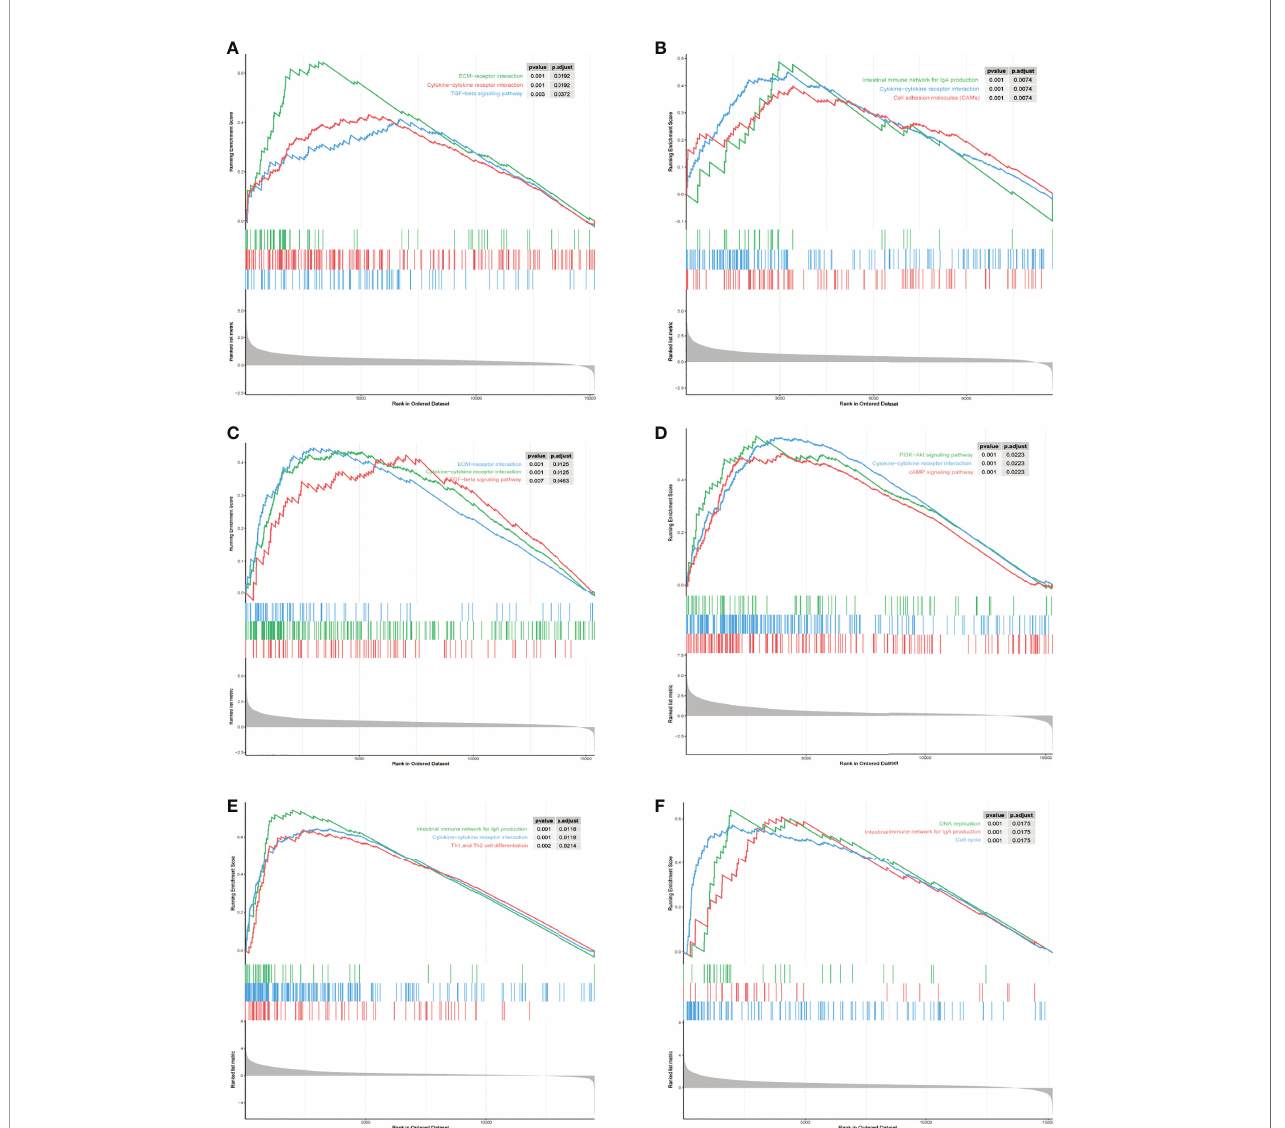
FIGURE 8 | Gene set enrichment analysis (GSEA) of hub genes in the TCGA-LIHC MAPK-RAP1A dataset. (A – F) Top three gene sets (according to GSEA enrichment score) enriched in the high-expression group of single hub genes. (A) PGF, (B) STMN1, (C) ANGPT2, (D) FLT3, (E) HSPA8, and (F)